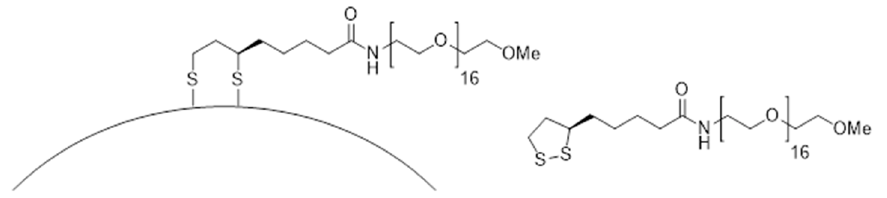
Figure 8. Hypothetic scheme of the grafting of sodium lipoate at the surface of bismuth NP.